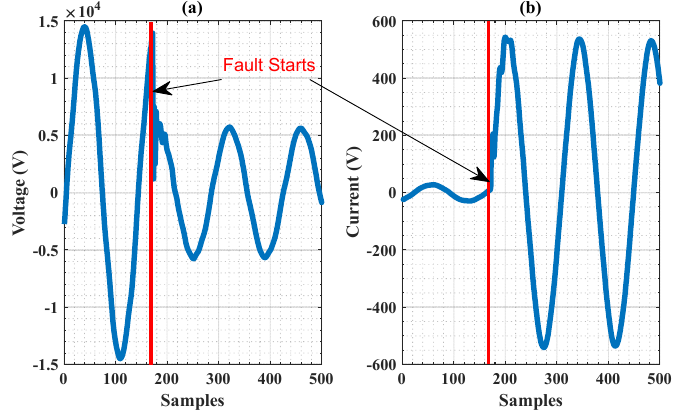
Figure 7. Recorded voltage ( a ) and current ( b ) waveforms.